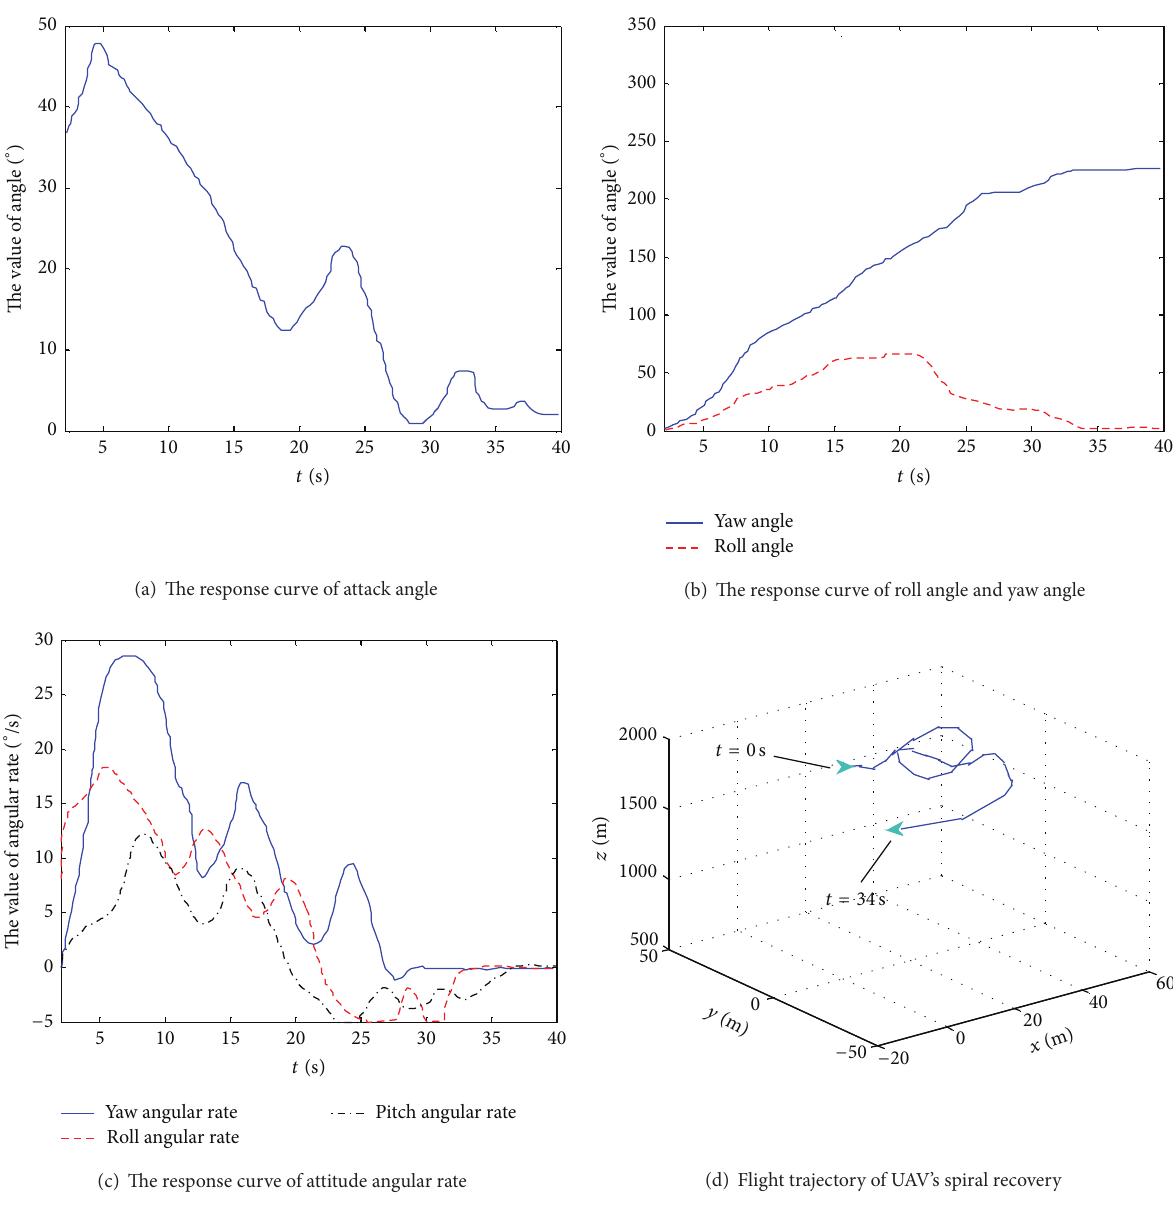
Figure 8: The dynamic process of UAV’s spiral